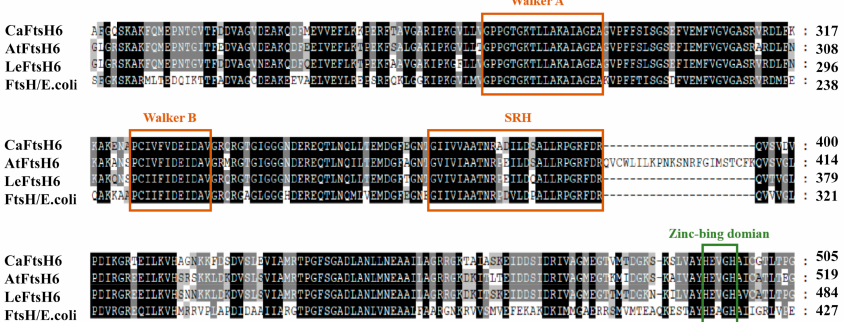
Figure 3. Analysis of the characteristics of FtsH protein structures. Multiple alignments of the deduced amino acid sequences of CaFtsH06, AtFtsH6, LeFtsH6, and FtsH/ E. coli , with the FtsH- specific motif shown by a rectangular box. Part of the protein sequence is drawn with a colored rectangle to match the figure in (Figure